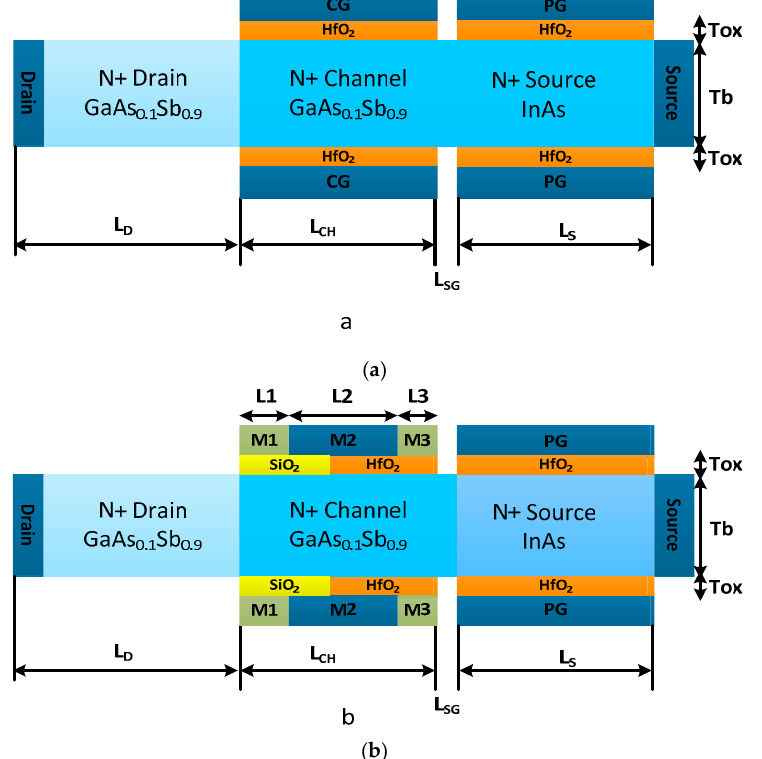
Figure 1. Cross-sectional view of ( a ) a conventional heterostructure junctionless tunnel field-effect transistor (HJLTFET); ( b ) a dual material gate-engineered (DMGE)-HJLTFET.